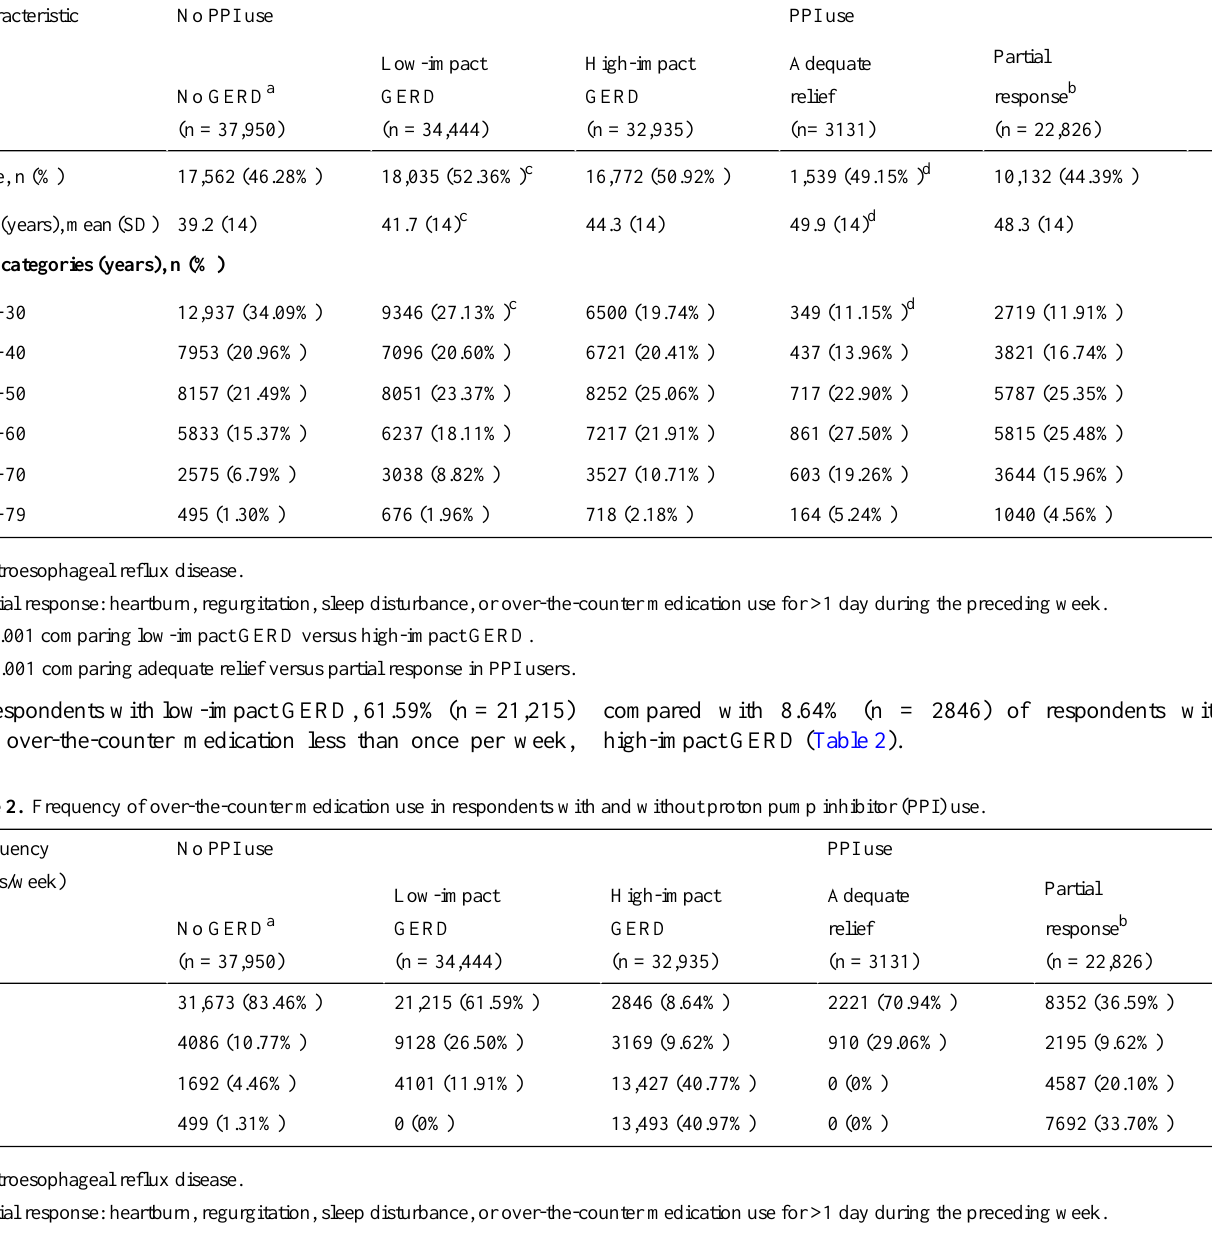
PPI useNo PPI useCharacteristic